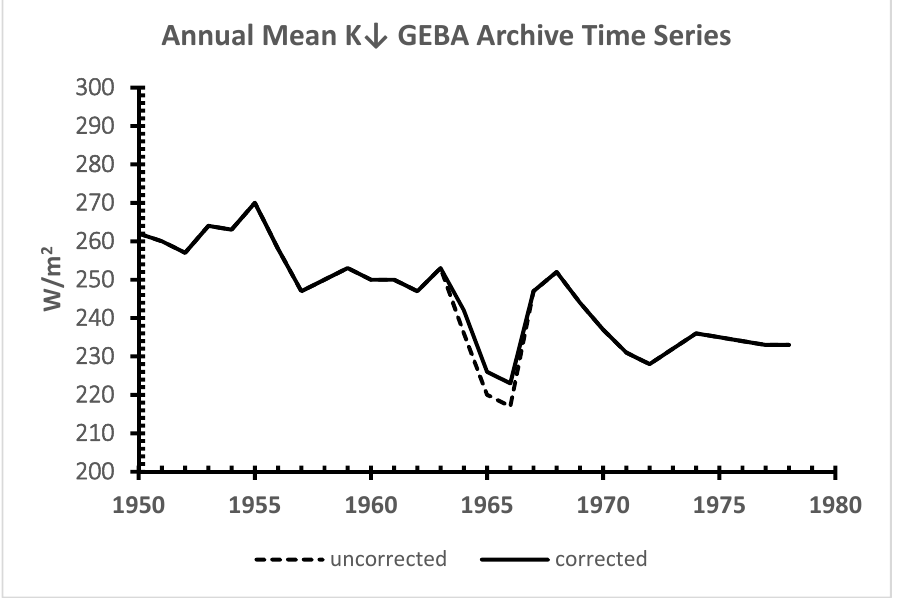
Figure 2. Annual mean shortwave irradiance K ↓ . Solid line-data from GEBA with interpolated missing years and correcting for known errors in instruments. Dashed line represents raw data from the GEBA Archives for the correction period.